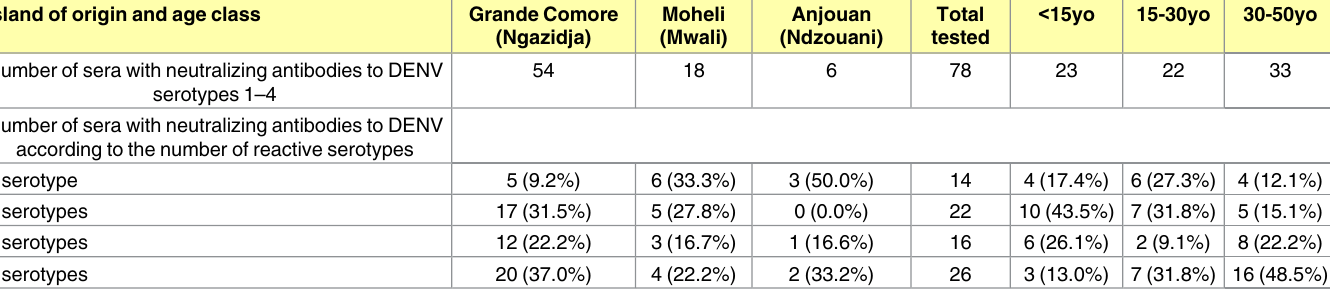
Table 5. Neutralizing antibodies for DENV serotypes1–4. Reactivity profile accordingto the numberof seroneutralized serotypesdetected in 78 out of 90 randomlyselectedDENV ELISA positive samples. Island of origin and age